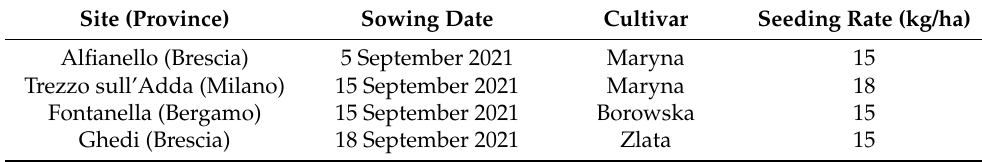
Table 1. Monitoring campaign sites, sowing dates, white mustard cultivars and seeding